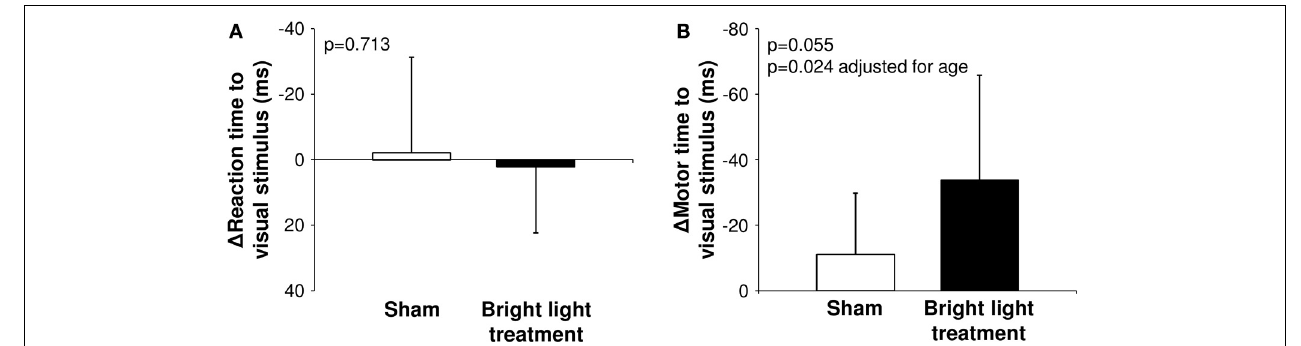
FIGURE 2 | The effects of bright light treatment via ear canals on the reaction time (A) and the motor time (B) to visual stimulus.